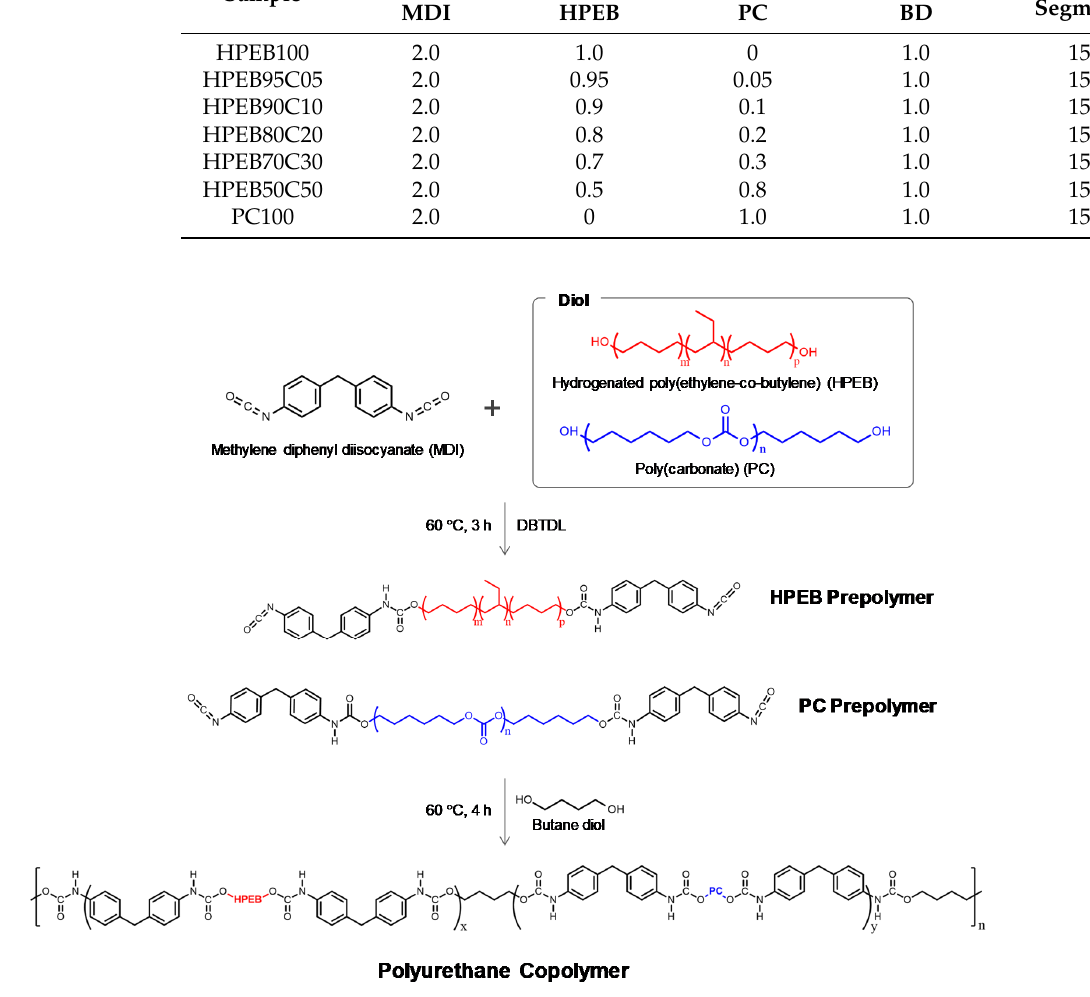
Figure 1. Synthetic scheme for the polyurethane copolymers .